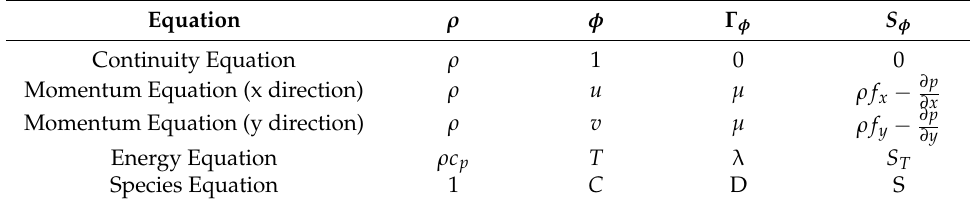
Table 1. Values of different governing equations.